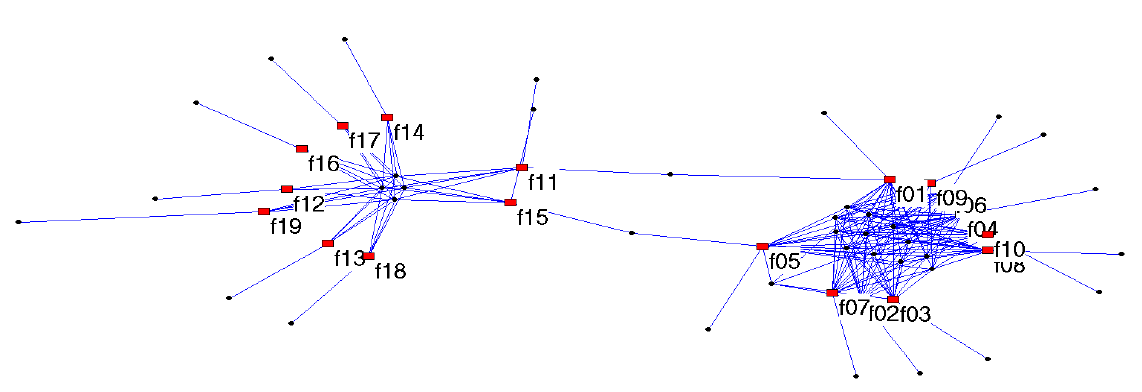
Figure 4. The DCSG graph for the 19 files described in Table